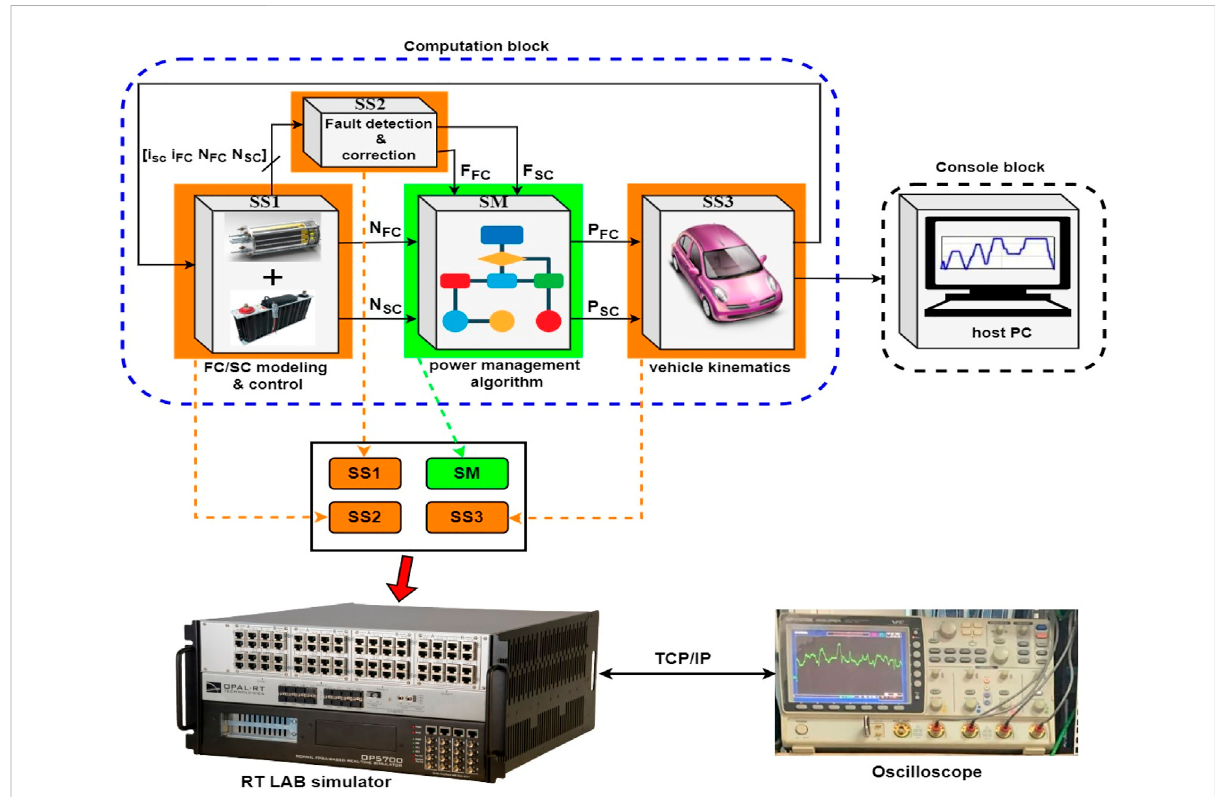
FIGURE 18 Real-time simulation using RT